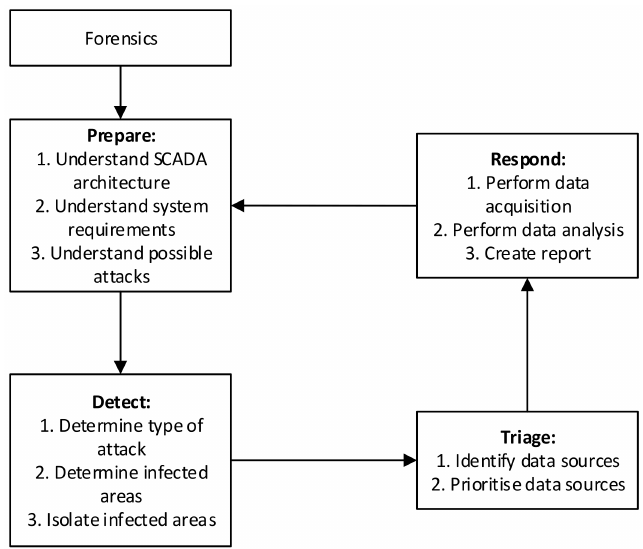
Figure 11. SCADA forensic incident response model